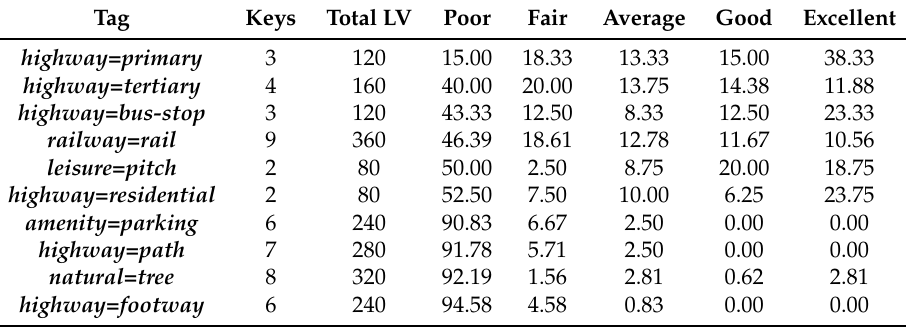
Table 14. Summary of all 40 cities in terms of the Likert Scale value for all target tags and suggested keys. “Total LV” is the number of keys multiplied by the number of